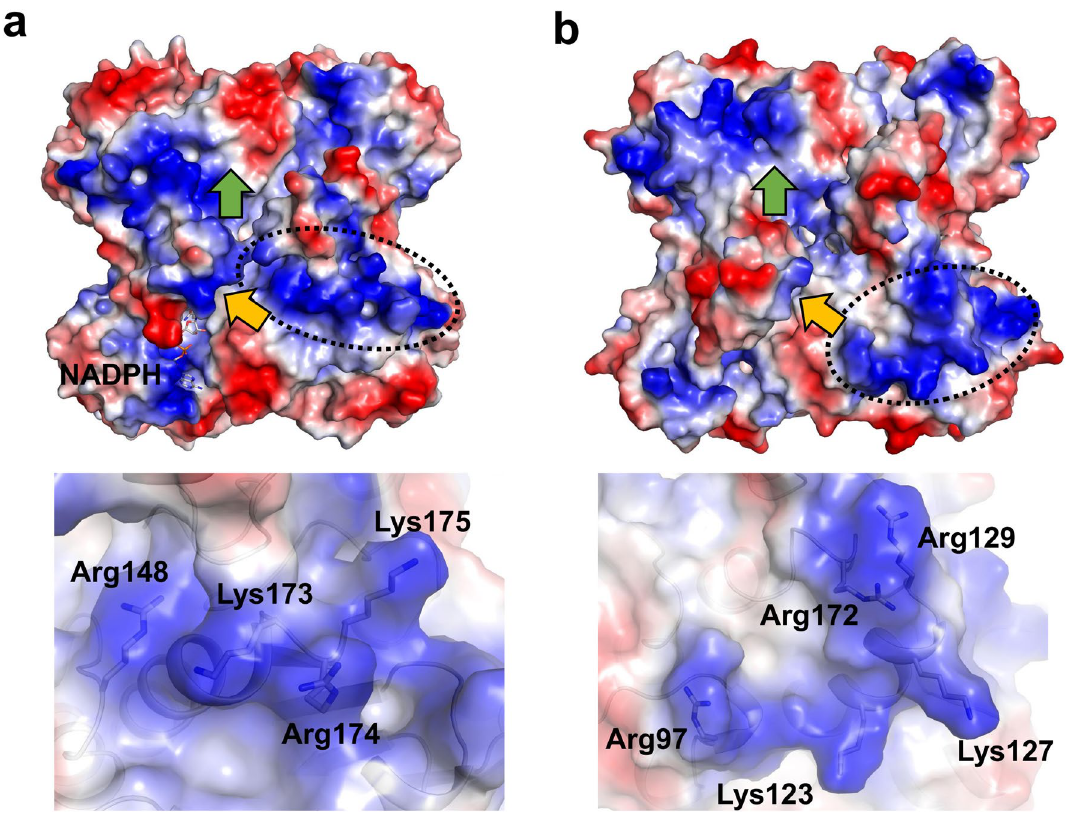
Figure 4. Electrostatic potential surface plot of the AbApeQ–NADPH complex ( a ) and AbFabG ( b ) tetramers. Entrance and exit of the PPant:APE substrate moiety are indicated by yellow and green arrows, respectively. Each surface with a dashed oval is blown up in each bottom panel, in which the residues presumed to interact with the respective substrate ACP are presented in stick models and